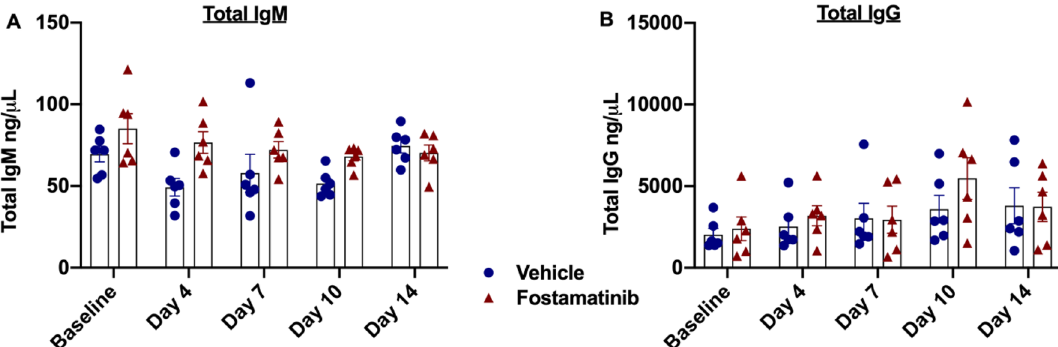
Figure 3. Fostamatinib treatment had no effect on total circulating IgM and IgG. Serum was analysed by ELISA for ( A ) total IgM and ( B ) total IgG levels. There was no significant difference at any measured time point between fostamatinib treated rats and vehicle treated rats for both IgM and IgG levels (n = 6 rats/group). Blue filled circle—vehicle, red filled